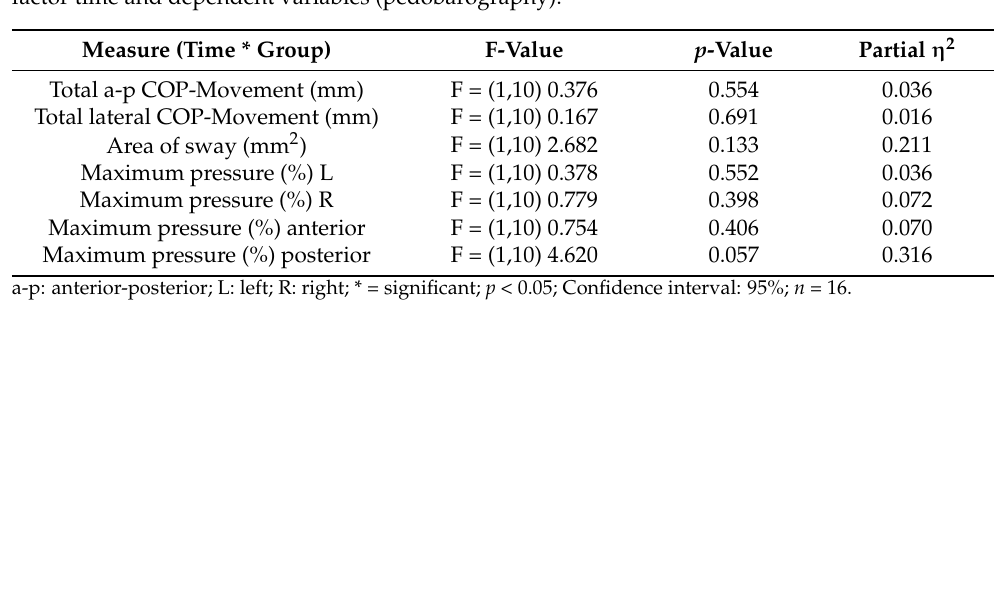
Table 5. Overview of MANCOVA results of and interaction effects between groups with the main factor time and dependent variables